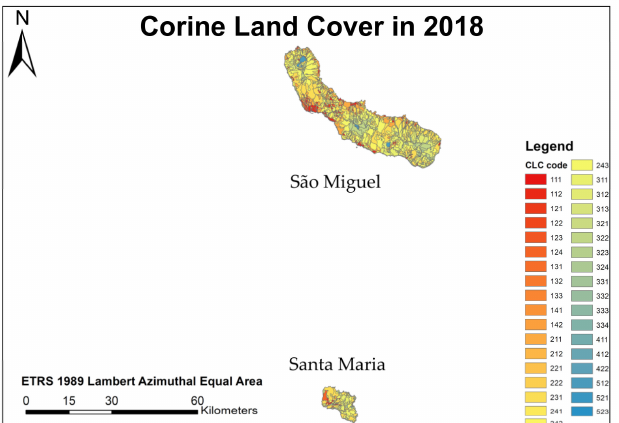
Figure A6. Thematic cartography regarding the land-use changes in the Eastern Group of Azores Archipelago in the year 2018.